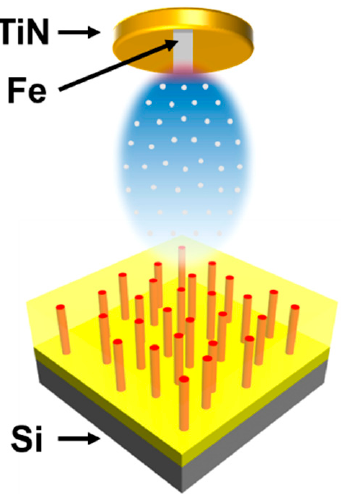
Figure 1. The schematic of the pseudo-composite TiN–Fe target with a Fe strip attached to a TiN disk. Pulsed laser deposition was used to deposit TiN–Fe vertically aligned nanocomposite thin films on Si substrates.